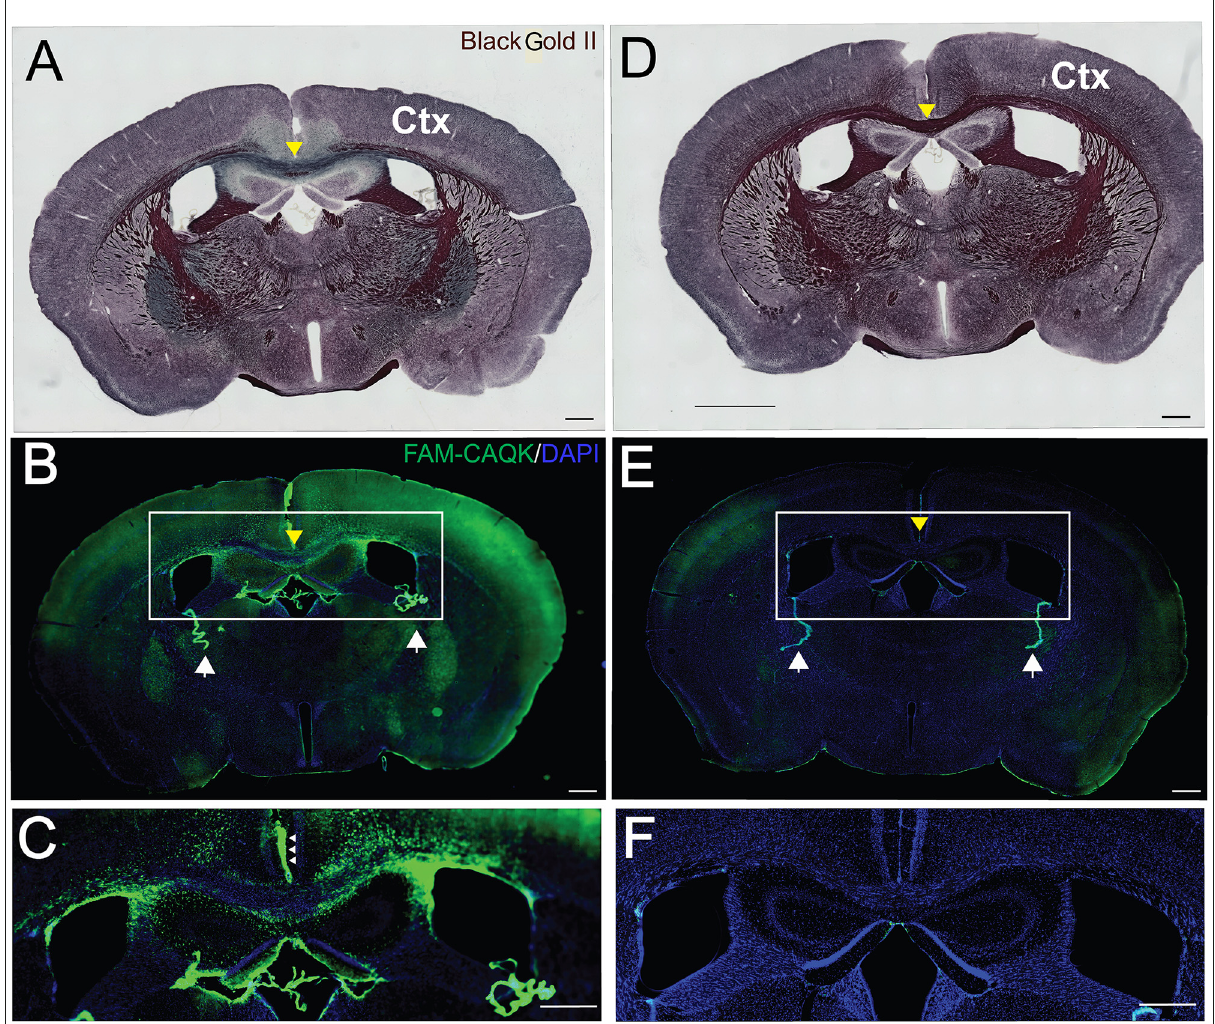
FIGURE2 CAQK peptide targets areas of demyelination in the cuprizone model. Histological Black Gold II staining detects myelin in coronal brain sections of (A) FAM-CAQK peptide-treated cuprizone treated mice and (D) naïve mice. Demyelination is indicated by the reduction of Black Gold II labeled myelin in multiple brain areas (A) in mice on the cuprizone diet compared to (D) control mice on a normal diet. Note in particular the reduced black myelin signal in the corpus callosum in (A) (yellow arrowhead) compared to (D) ; images at 10 × magnification. (B) FAM-CAQK peptide (green) targets the demyelinated areas including the cortex (Ctx) in cuprizone-treated mice, and in (E) is absent from myelin in the naïve brain; images at 20 × magnification with identical exposure time. In both conditions, circulating peptide associates with the choroid plexus (white arrows in B,E ) that separates the blood from cerebral spinal fluid. The framed regions with the centered corpus callosum (yellow arrow) are shown enlarged in (C,F) , correspondingly. Ependymal cells facing the cerebral spinal fluid (small arrows in C ) harbor the peptide. DAPI staining (blue) demarcates cellular nuclei in (B,C,E,F) . Scale Bar = 500 µ m.